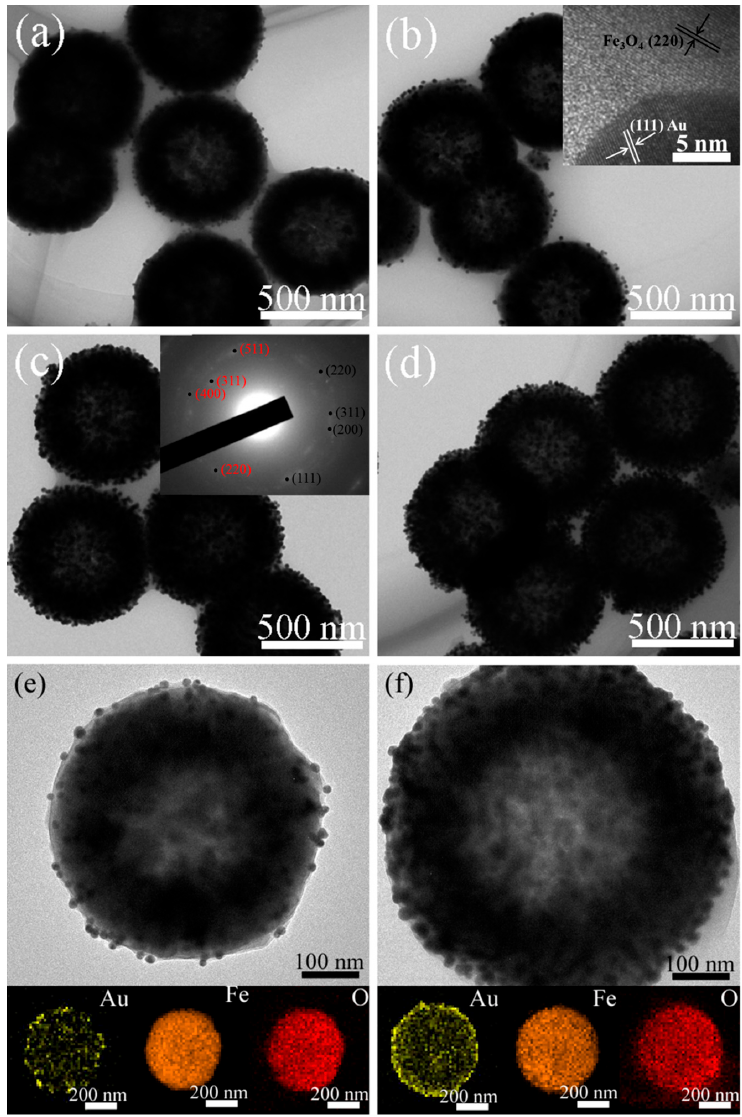
Figure 4. TEM images of Fe 3 O 4 -Au 5 mL ( a ) and Fe 3 O 4 -Au 20 mL with the HRTEM image (inset) ( b ), Fe 3 O 4 -Au 40 mL with the SAED pattern (inset) ( c ) and Fe 3 O 4 -Au 60 mL ( d ). TEM images of single Fe 3 O 4 -Au 5 mL ( e ) and Fe 3 O 4 -Au 60 mL ( f ) microspheres and corresponding EDS elemental mapping images (Au, Fe and O).